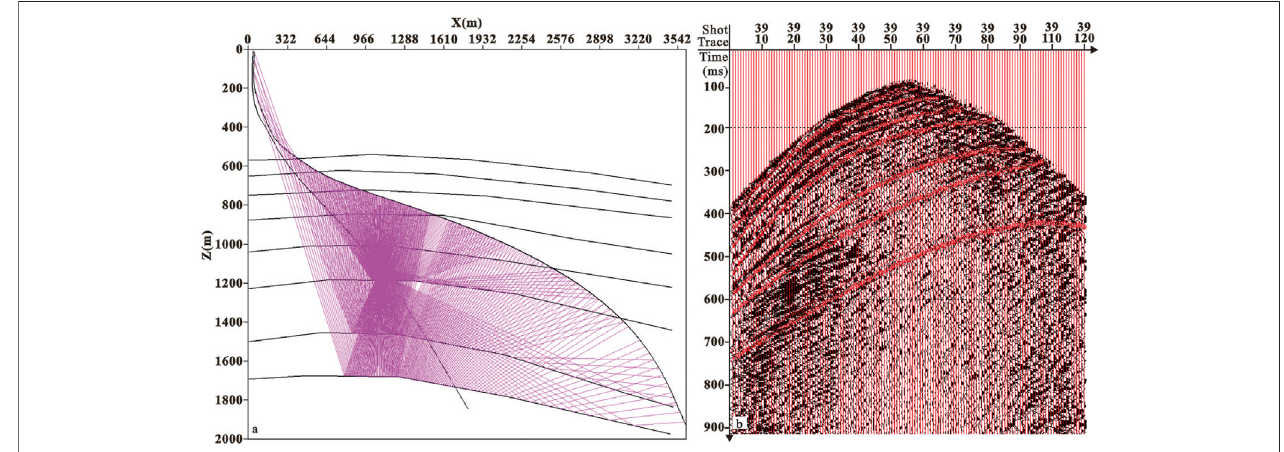
FIGURE 12 | Ray path diagram and comparison diagram of wave fi eld interaction. (A) Ray path and (B) wave fi eld interaction comparison diagram.